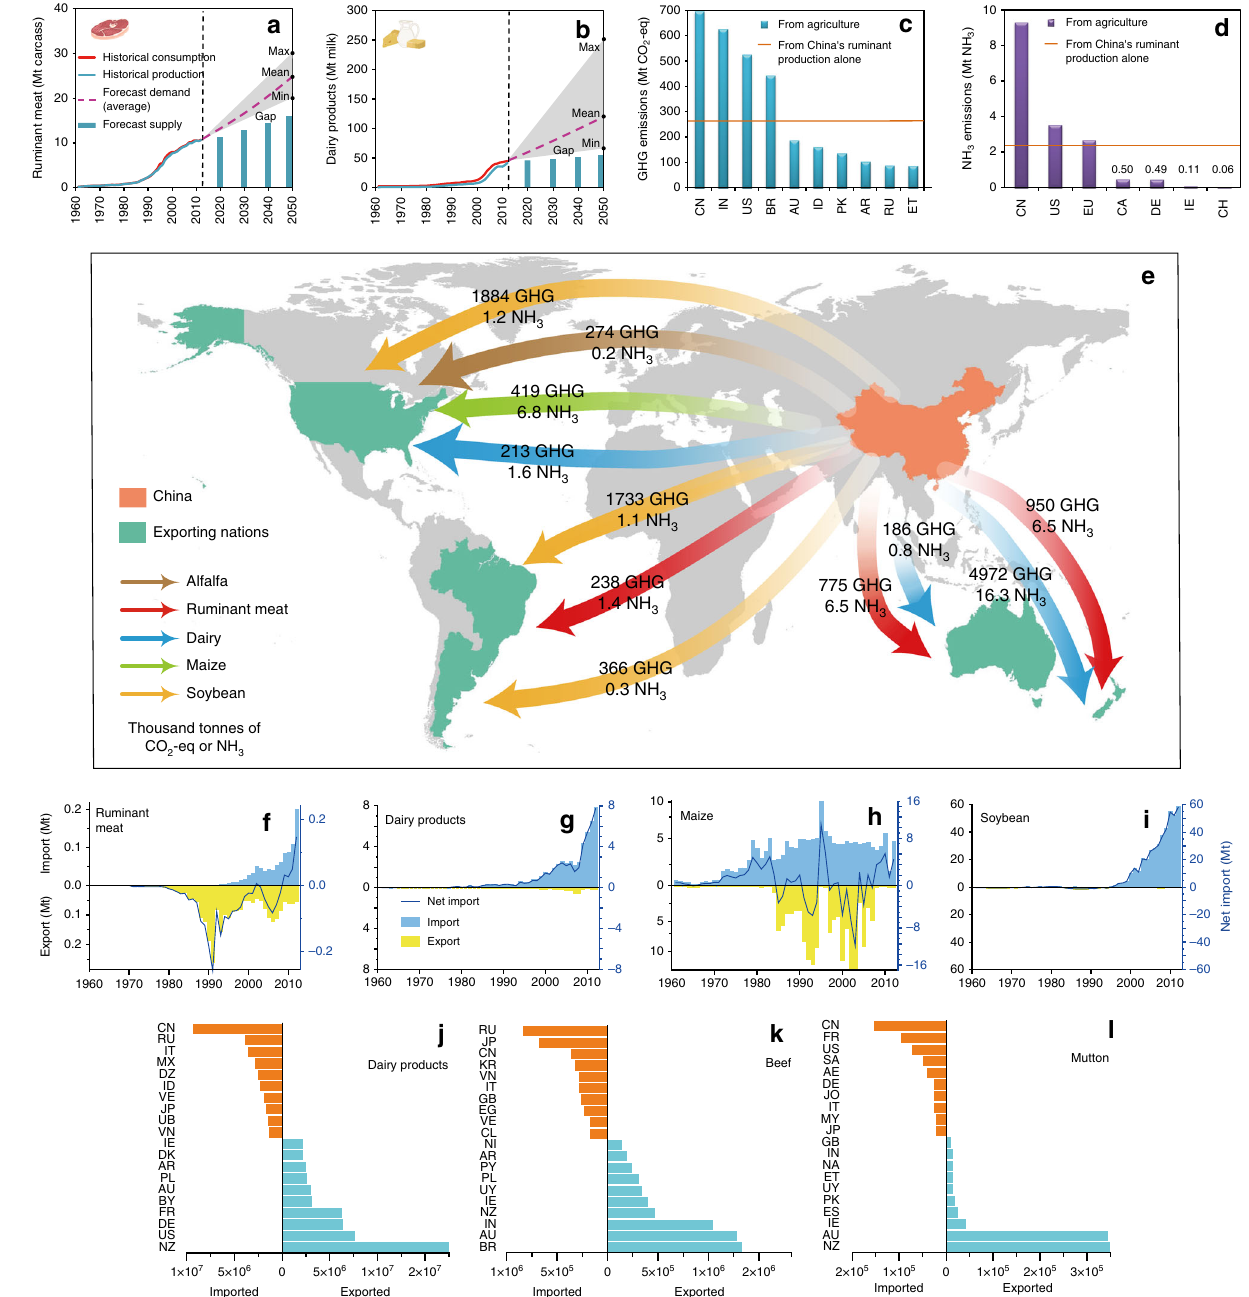
Fig. 1 Trends in China ’ s consumption, production and trade of ruminant products, and the associated local and global transfer of environmental impacts. Ruminant meat and the gaps ( a ), dairy products and the gaps ( b ). Greenhouse gas (GHG) emissions ( c ), and ammonia (NH 3 ) emissions ( d ) in domestic ruminant production in China is signi fi cantly higher than that of other nations. Moreover China has a large global environmental impact ( e ) through the associated negative externalities of rising net imports of ruminant meat ( f ) and dairy products ( g ) for human consumption, and maize ( h ) and soybean ( i ) for livestock feed from 1961 to 2012. China is now a leading net importer of ruminant products ( j – l , data from 2012, unit: t). Nations used to analyse global consumption trend see Supplementary Table 36. Country codes see Supplementary Table 37. Maps are created in ArcGIS (version 10.1,